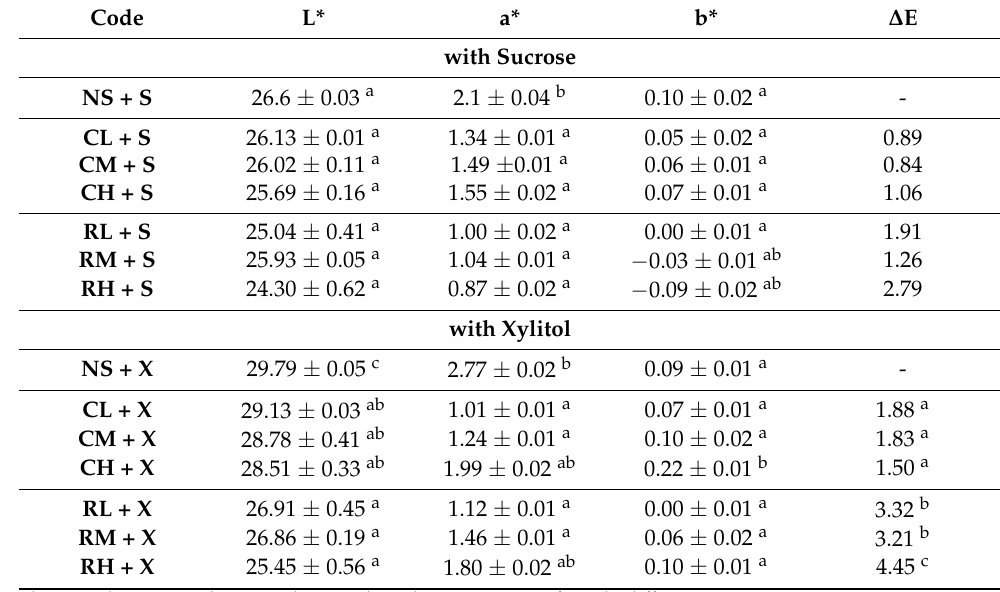
Figure 7. Syneresis of black jelly-like desserts prepared on the basis of chemically ( a , b ) or physically ( c , d ) modified starches sweetened with xylitol. Table 3. Measurements of the colour of blackberry kissels (L*, a*,